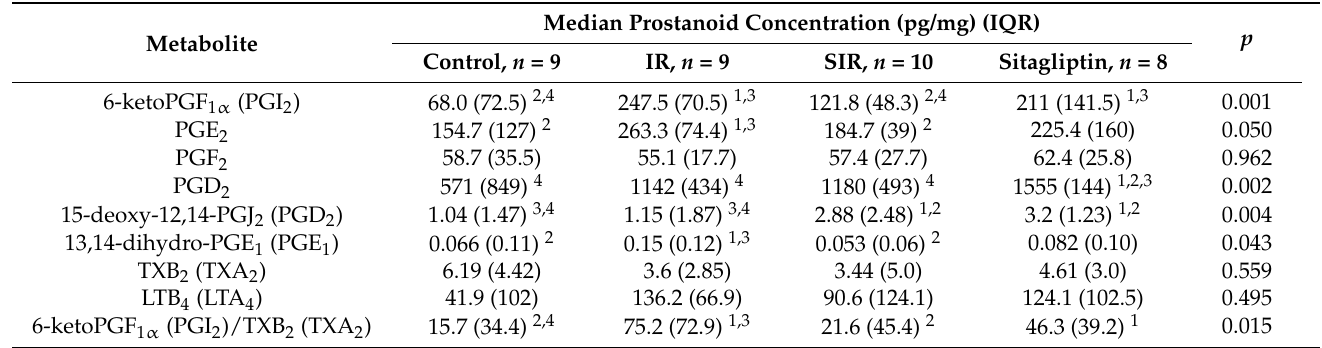
Data were analyzed using Kruskal–Wallis H test with Conover post-hoc analysis and are presented as medians with IQR. 1 , significantly different from the control group; 2 , significantly different from IR group; 3 , significantly different from SIR group; 4 , significantly different from sitagliptin group. IQR, interquartile range; n , number of observations; IR, ischemia-reperfusion; SIR, sitagliptin pretreatment, and ischemia-reperfusion. Metabolite precursors are given in